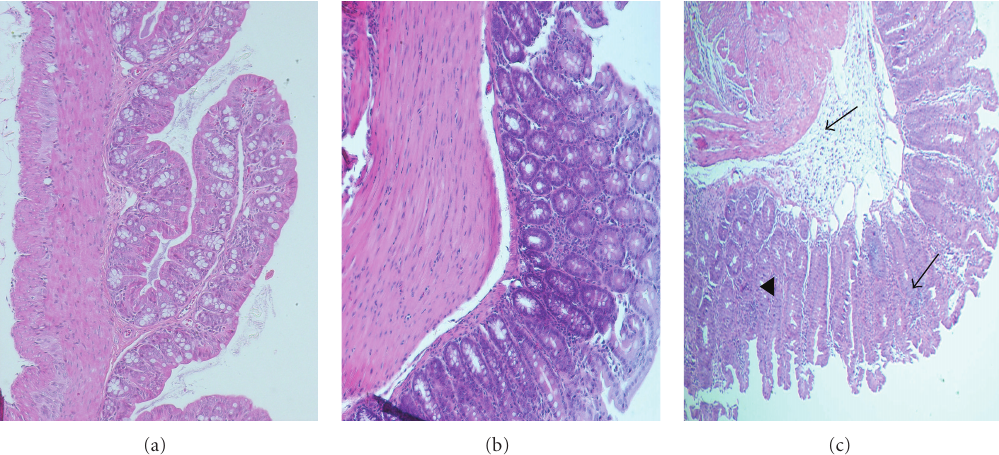
Figure 2: Hematoxylin-eosin-stained colon sections of Il10 − / − and C57 mice. (a) Colon section ( × 20) from a non-inflamed C57 mouse at 12 weeks of age. (b) Colon section ( × 100) from an Il10 − / − mouse at 7 weeks of age with no inflammation. (c) Moderate to severe inflamed colon section ( × 40) from an Il10 − / − mouse at 12 weeks of age. Lesions involve most of the colon section with mainly monocyte and neutrophil infiltration ( ← ), crypt abscesses, and loss of crypt and goblet cells ( (cid:2) ).